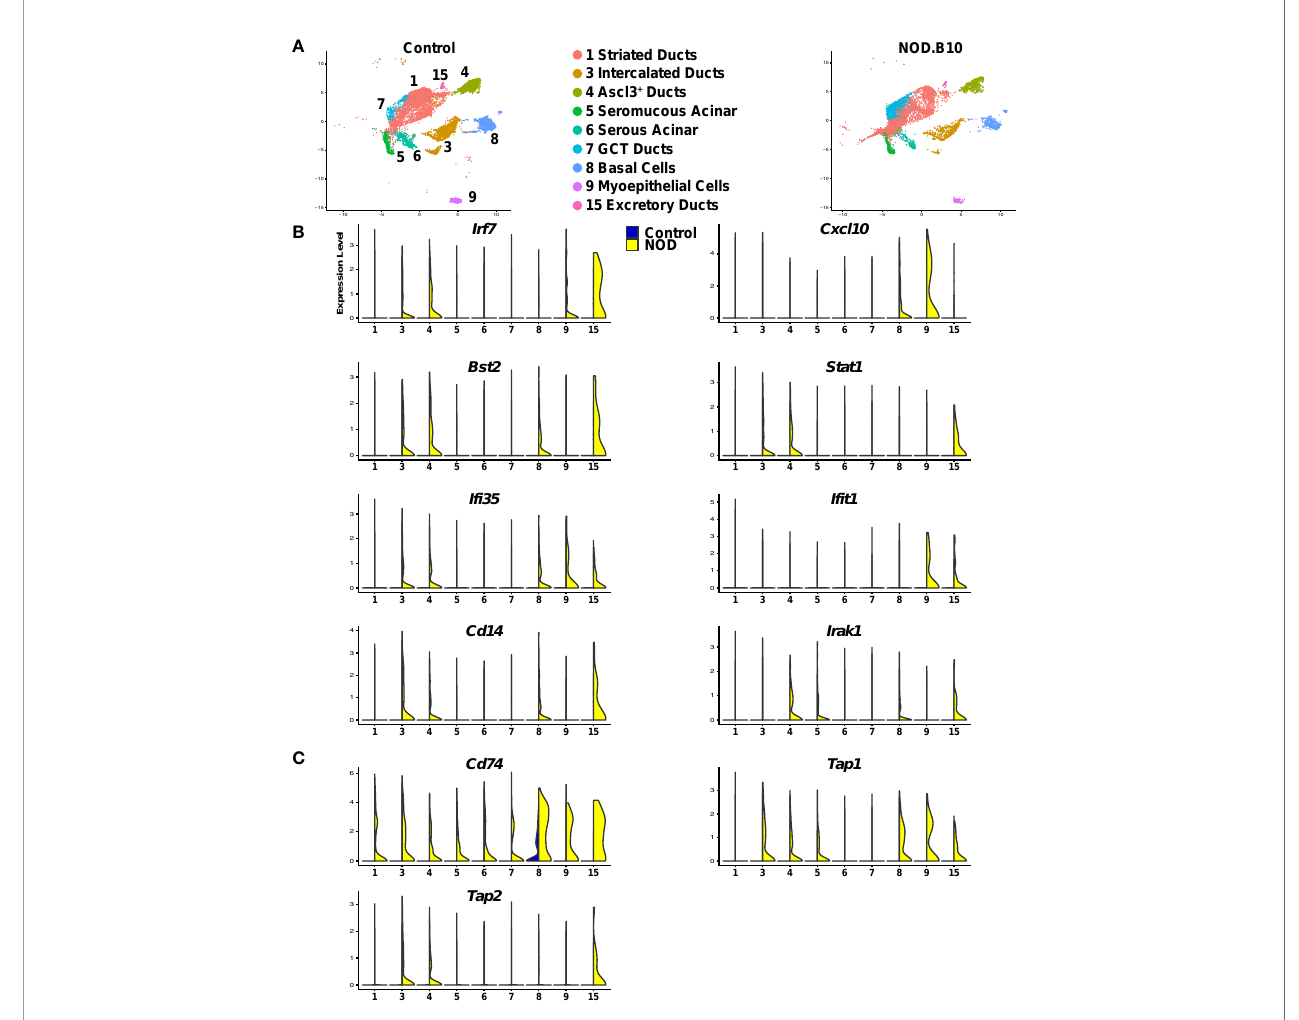
FIGURE 7 | Activation of Immune Responses of Mouse SS Salivary Gland Epithelial Cells. (A) UMAP visualization of the epithelial cell populations of control and NOD.B10 mouse SMGs based on hierarchical clustering analysis performed in Figure 4A . Epithelial cell cluster identities are shown. (B, C) Violin plots demonstrate expression of various immune related genes in the epithelial cell populations of control and NOD.B10 mouse